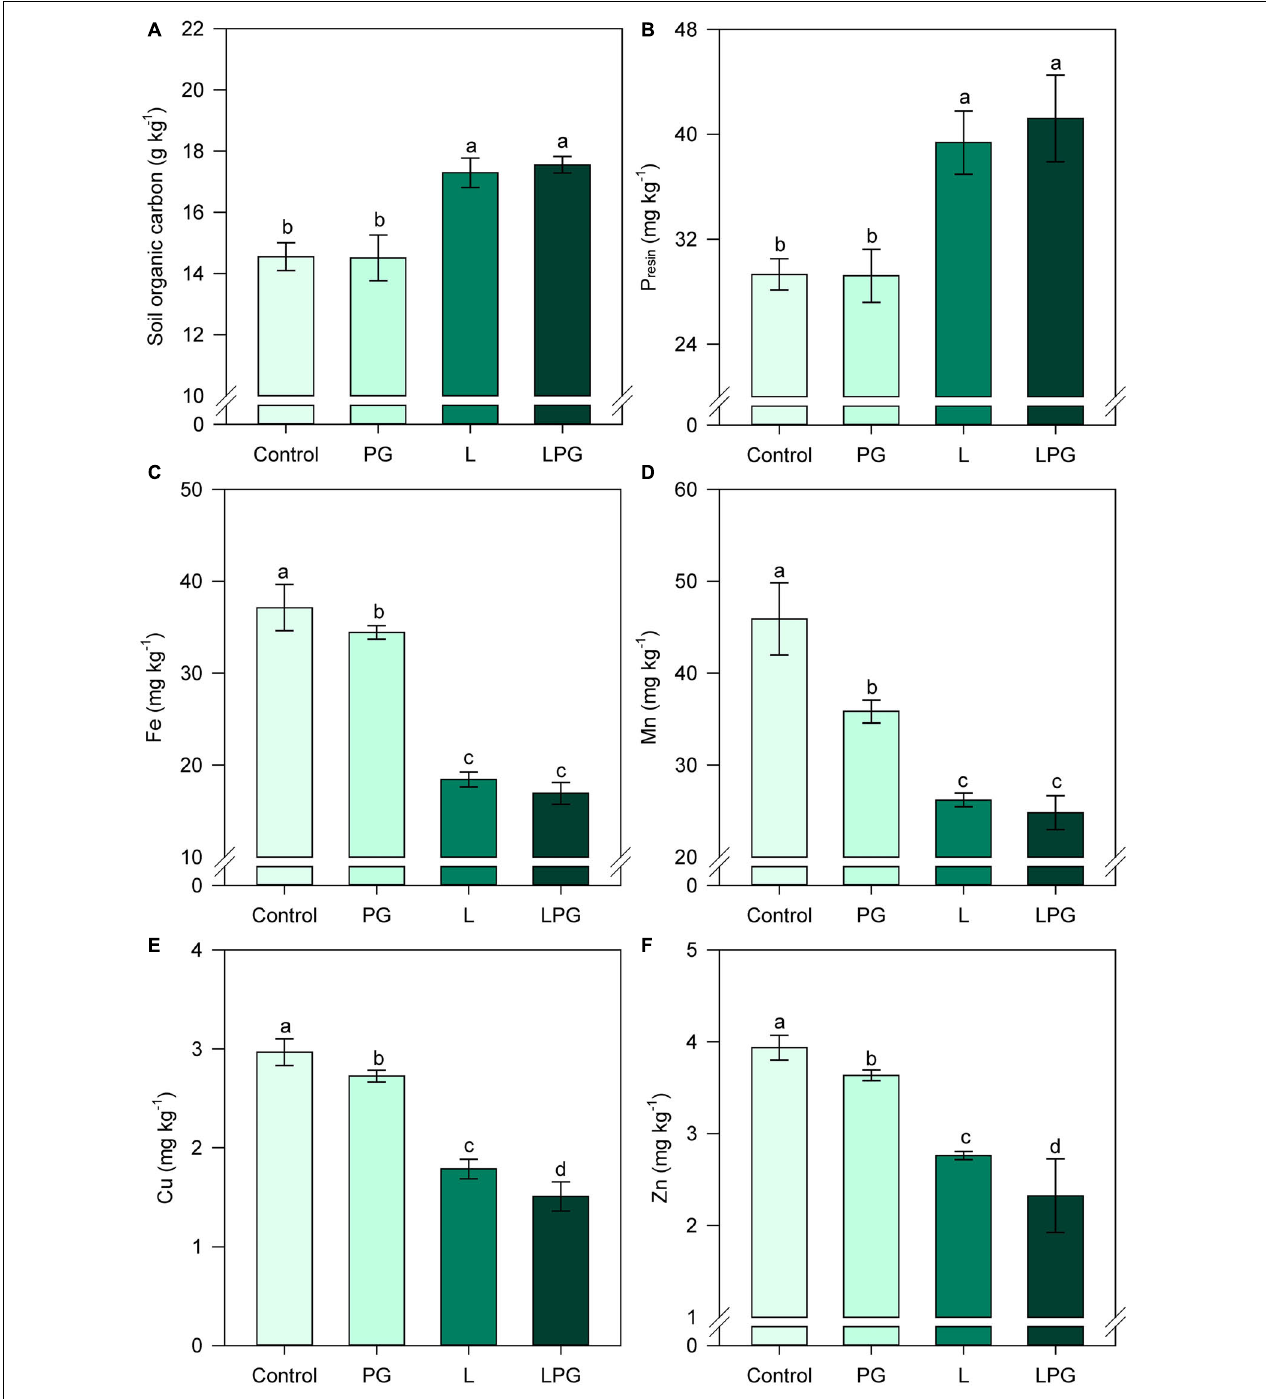
FIGURE 3 | Changes in soil organic carbon (SOC) (A) , phosphorus (P) (B) , iron (Fe) (C) , manganese (Mn) (D) , copper (Cu) (E) , and zinc (Zn) (F) at 0.0–0.2 m depth as affected by surface-applied lime (L), phosphogypsum (PG), and lime + phosphogypsum (LPG) treatments. Different lower-case letters for each soil depth indicate significant differences between treatments by Student’s t -test at p ≤ 0.05. Error bars express the standard error of the mean ( n =